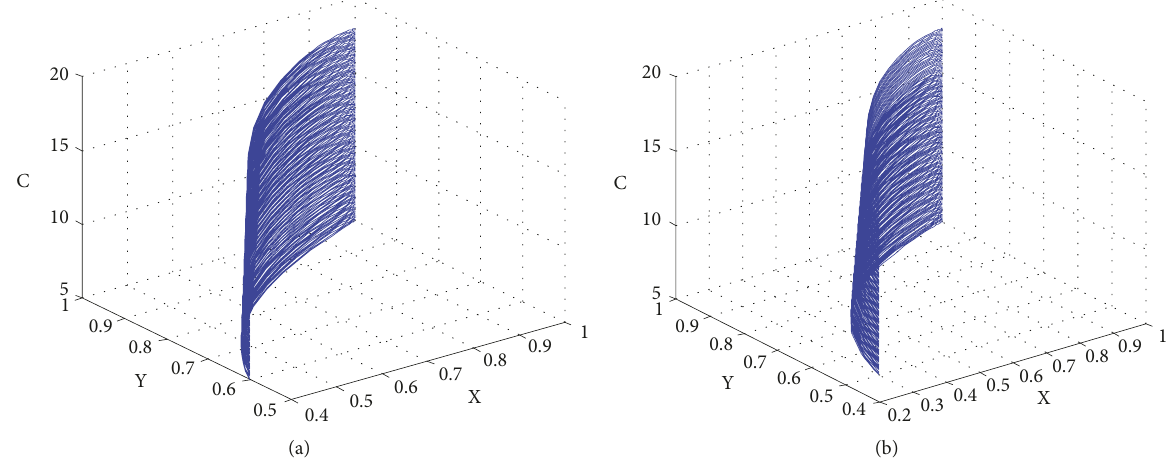
Figure 10: The change of C with respect to the initial values of (0.4,0.6) and (0.3,0.5) in Scenario 1.